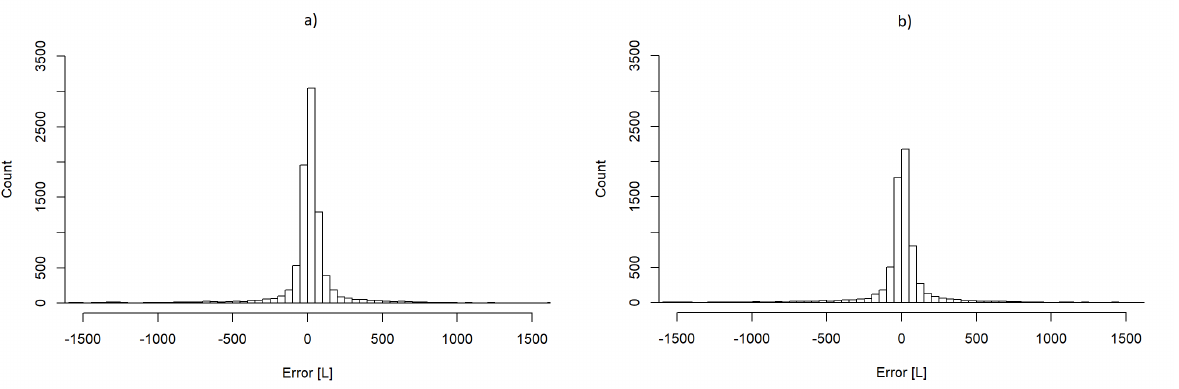
Figure 10. The weekly error distributions for the proposed ( a ) and trivial ( b ) models—prediction of the total demand for gas in a three-month period for a distribution station serving 749 customers.